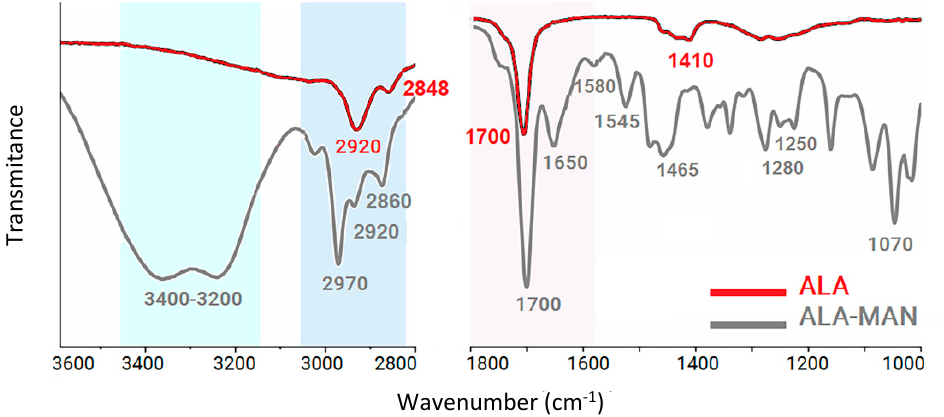
Figure 1. The attenuated total reflection Fourier transform infrared (ATR-FTIR) spectra for the covalent bonding of 2-aminoethyl 2,3,4,6-tetra- O -acetyl- α - d -mannopyranoside hydrochloride (MAN) molecules on lipoic acid (ALA) moieties.